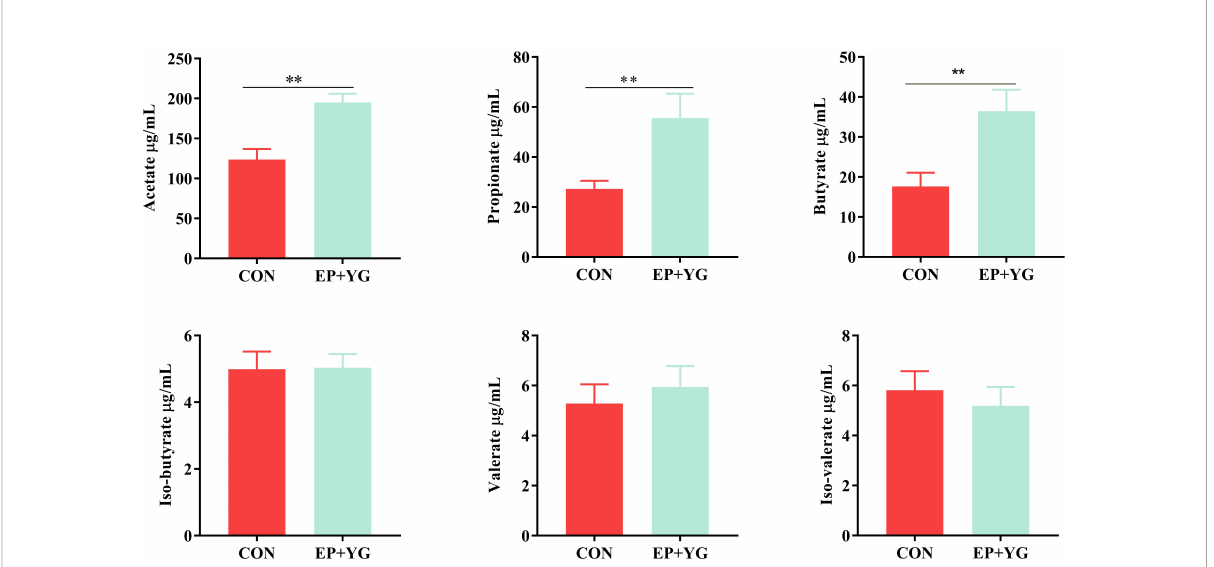
FIGURE 2 Effect of EP+YG supplementation on caecal content SCFA concentration in broiler chickens. n=8, ** indicate signi fi cant differences at P < 0.05 and P < 0.01,